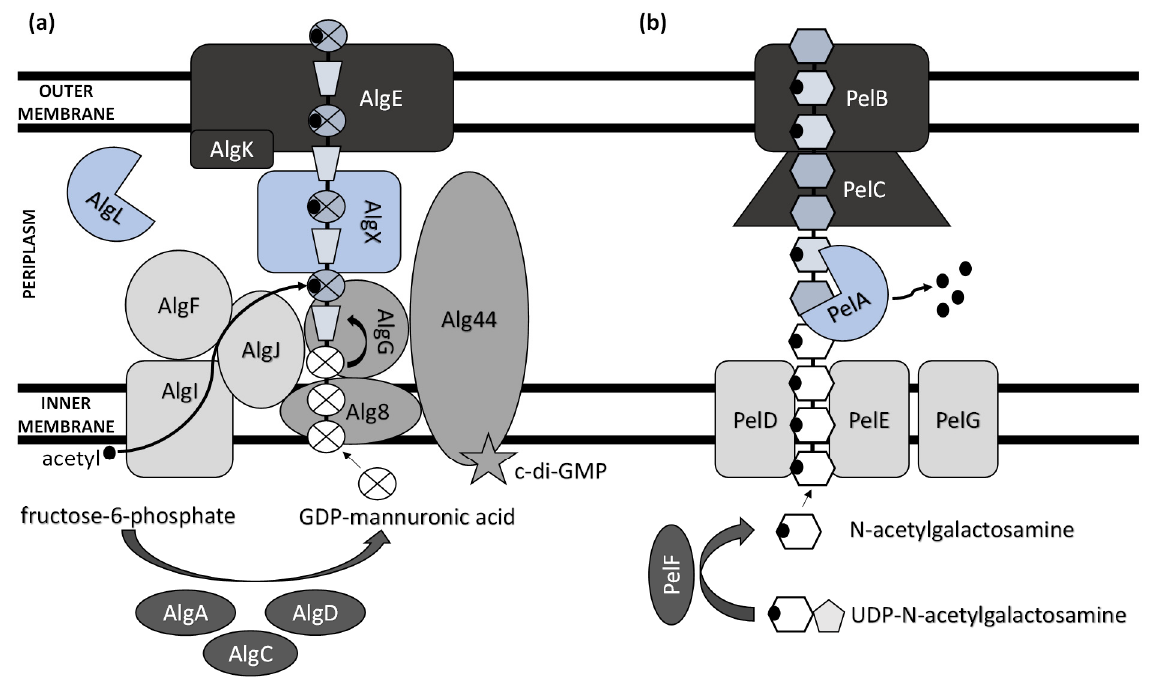
Figure 1. Schematic model of ( a ) alginate and ( b ) Pel polysaccharide biosynthetic machinery.